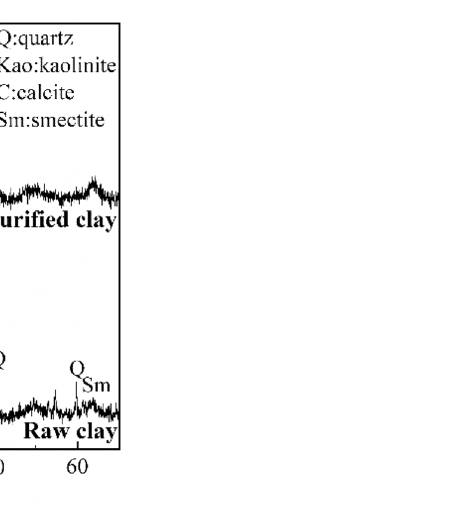
Figure 2. XRD patterns of the raw clay and purified